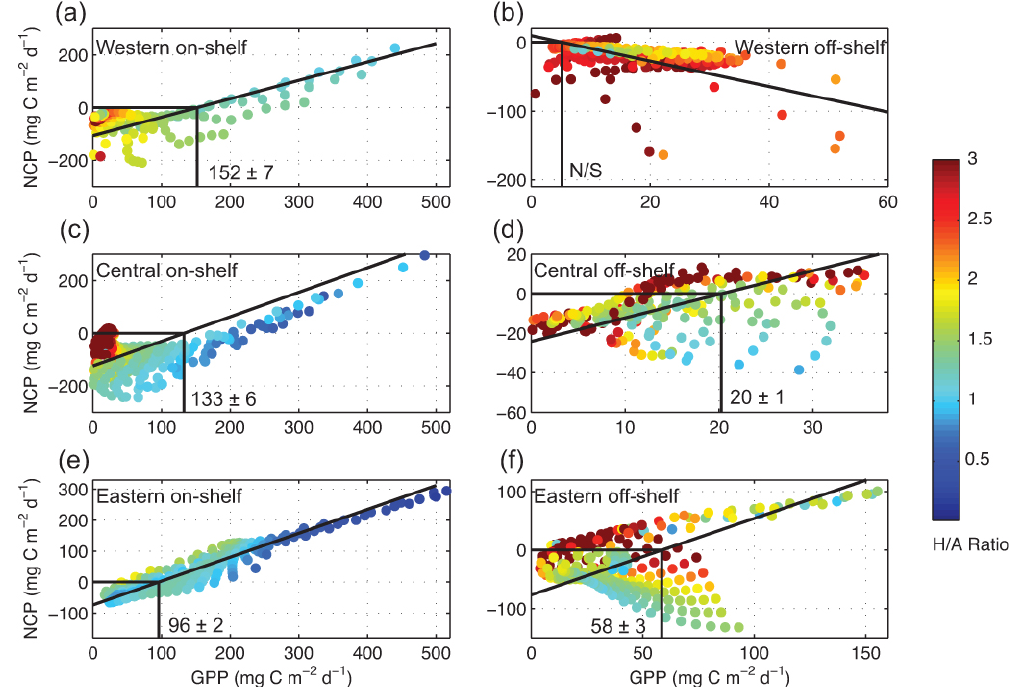
Figure 11. Model II regressions of net community production (NCP) against gross primary production (GPP) in the surface layer of the on-shelf and off-shelf zones (delimited by the 100m isobath). Every dot represents a pixel extracted from the gridded composites and further colored according to the total heterotroph to autotroph biomass ratio ( H/A ratio). The threshold GPP (i.e., GPP at which NCP becomes positive) is showed on every image, except for the western off-shelf area where the regression was not significant (N/S). The western, central and eastern regions correspond to the areas delimited by 136–141 ◦ W, 131–136 ◦ W and 126–131 ◦ W, respectively (Fig.